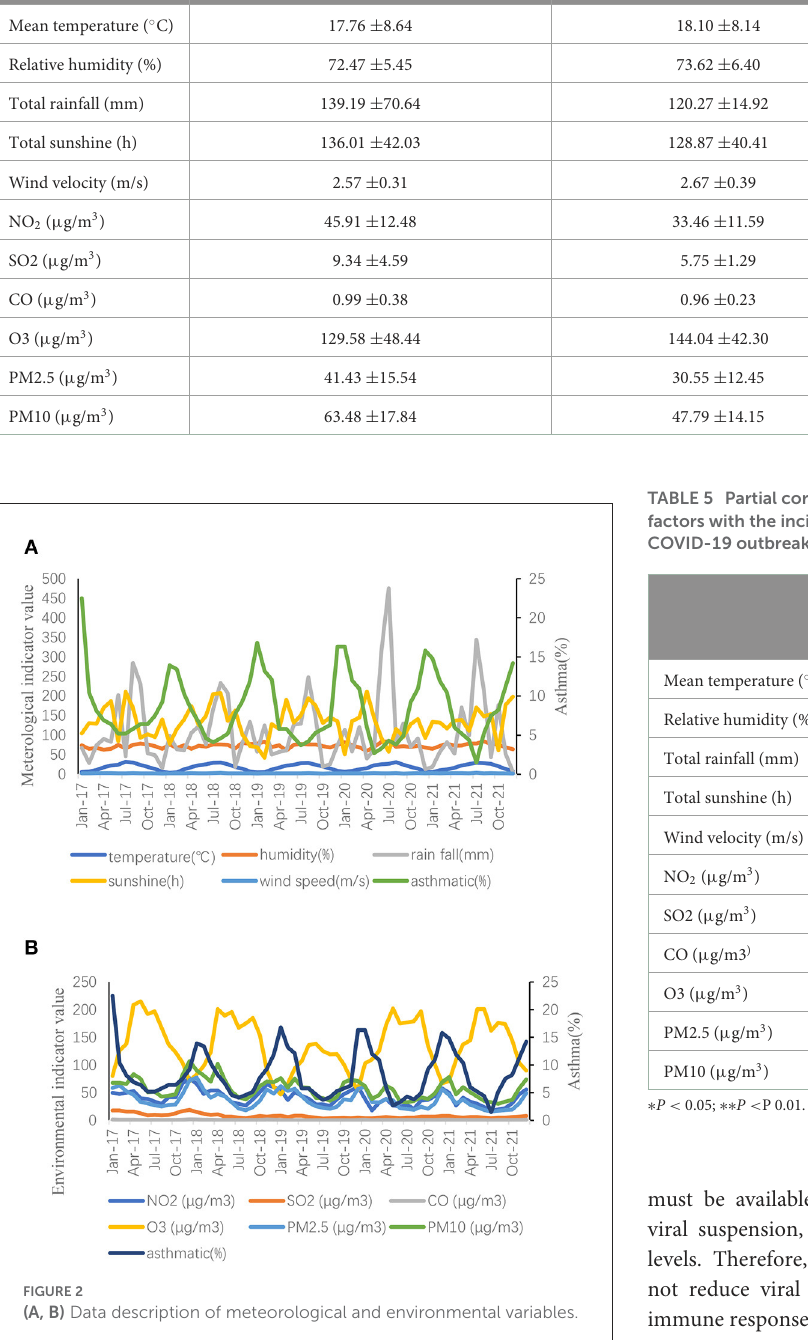
TABLE 4 Annual mean values of meteorological and environmental variables before and after the outbreak of COVID-19. Before the COVID-19 pandemic After the COVID-19 outbreak